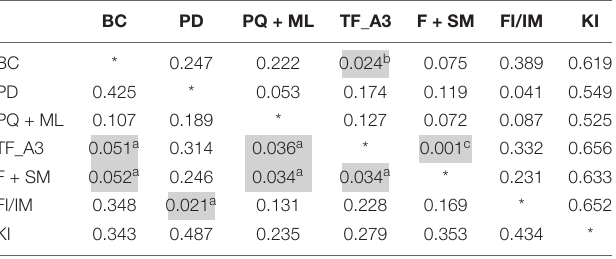
TABLE 2 | Genetic ( F ST , below diagonal) and phylogeographic ( (cid:56) ST , above diagonal) structure values between the South American localities of Bahía Camarones (BC), Puerto Deseado (PD), Punta Quilla and Monte León (PQ/ML), Tierra del Fuego (TF_A3), Fitzroy and the Strait of Magellan (F + SM); the Falkland Islands/Islas Malvinas (FI/IM); and Kerguelen Islands (KI).